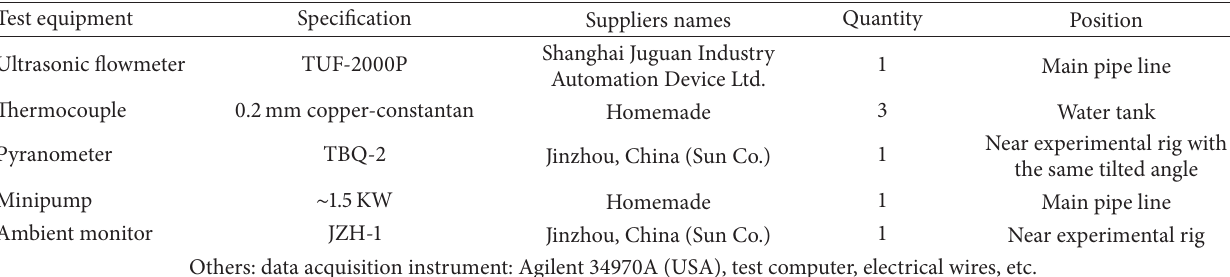
Table 2: Specification of the test